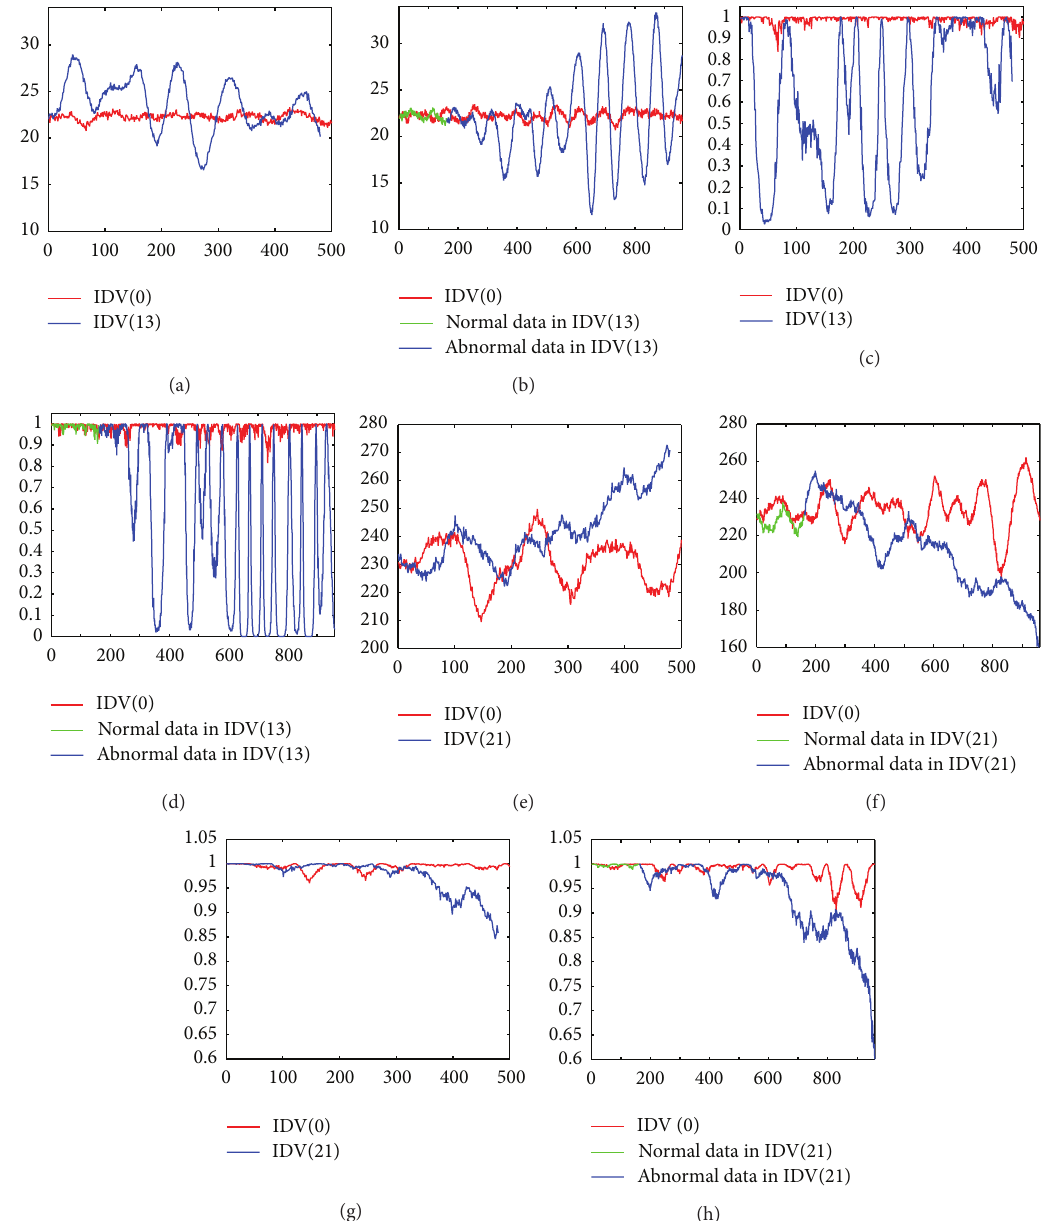
Figure 1: The comparison of original data and the data after preprocessing. (a)–(d) illustrate the comparison on the 46 th measurement signals on IDV(0) and IDV(13): (a) original training data; (b) original testing data; (c) training data after preprocessing; (d) and testing data after preprocessing. (e)–(h) illustrate the comparison on the 19 th measurement signals on IDV(0) and IDV(21): (e) original training data; (f) original testing data; (g) training data after preprocessing; (h) and testing data after